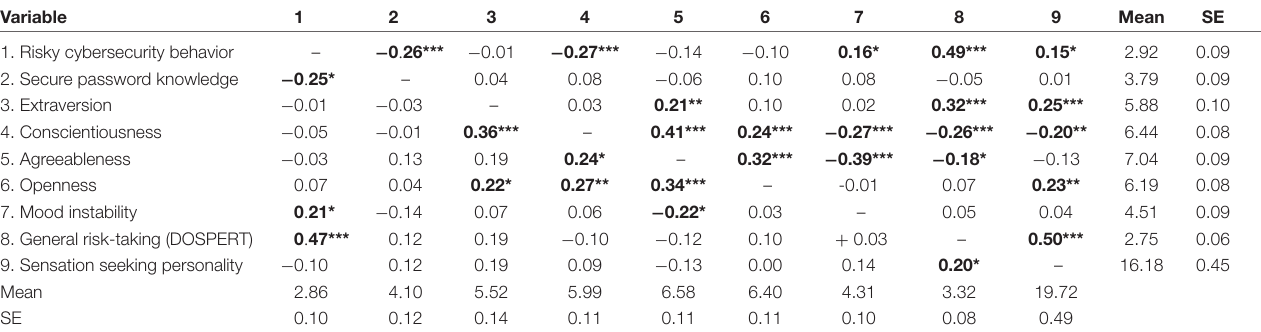
TABLE 1 | Summary of descriptive statistics and correlations for men (lower half of matrix) and women (upper half of matrix).